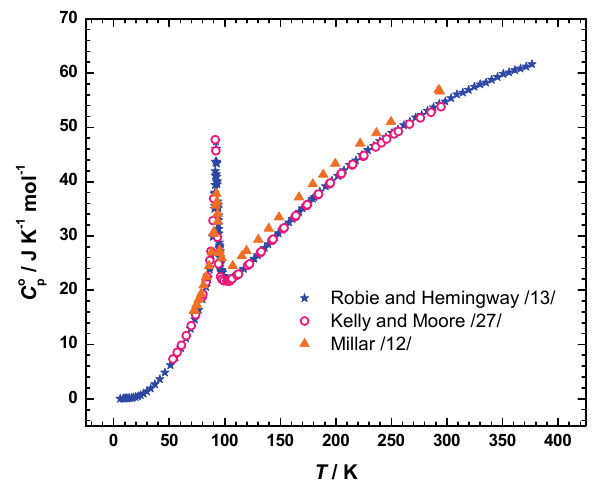
Figure 9. Comparison of low-temperature heat capacity of MnO 2 reported by Millar [12], Kelly and Moore [27], and Robie and Hemingway [13].